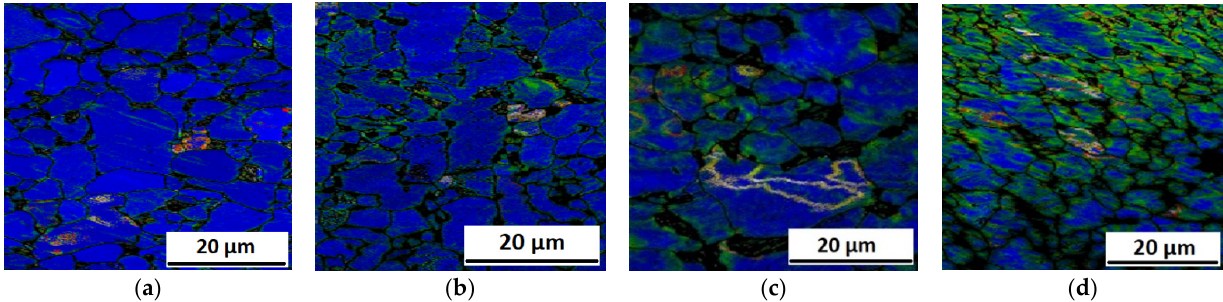
Figure 4. EBSD color map of Al 5083 alloy after ECAPed processing. ( a ) No pass, ( b ) first pass, ( c ) second pass, ( d ) third pass at ambient temperature.